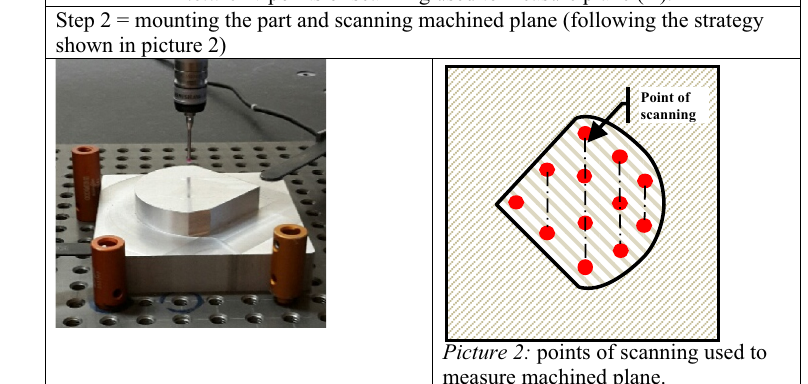
Picture 2: points of scanning used to measure machined